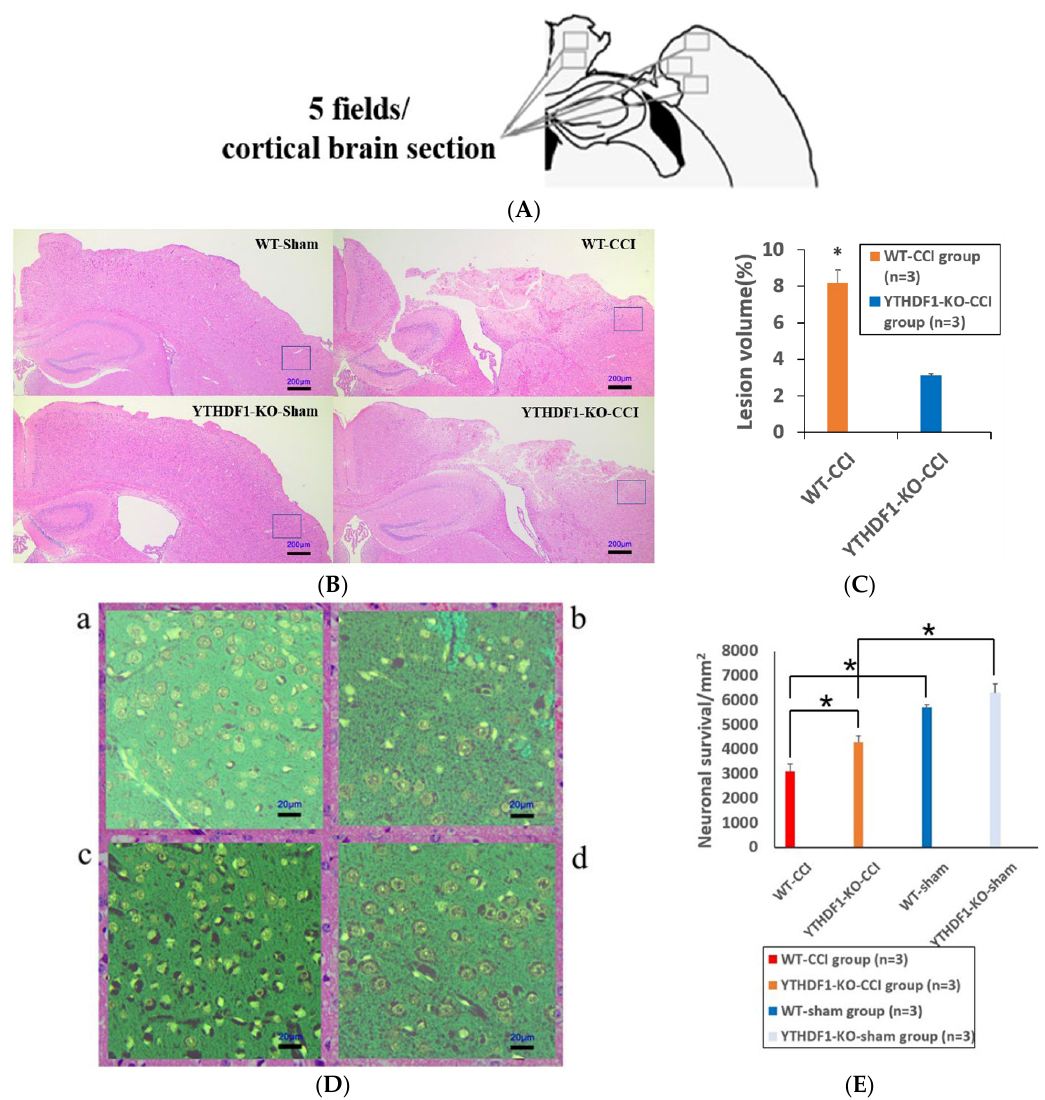
Figure 1. Histological images of HE coronal sections showing the brain tissue losses and neuronal survivals at 3 days post-CCI. ( A ) Diagrammatic representation of perilesional cortex sections at − 1.20 mm from the bregma; 5 fields of the brain section were counted. ( B ) The lesion volume increased in CCI groups compared to sham groups (n = 3 mice per group). Scale bars: 200 μm. ( C ) The lesion volume was quantified (calculation formula: lesion volume (%) = (healthy side volume-in- jured side volume)/healthy side volume ×100%). * p < 0.05. ( D ) The neuronal survivals decreased in CCI groups compared to sham groups. ( a ) WT-sham group; ( b ) WT-CCI group; ( c ) YTHDF1-KO-sham group; ( d ) YTHDF1-KO-CCI group; Scale bars: 20 μm. ( E ) The number of neuronal survivals (5 fields/ section) was quantified. Values are means ± SEs. * p < 0.05.